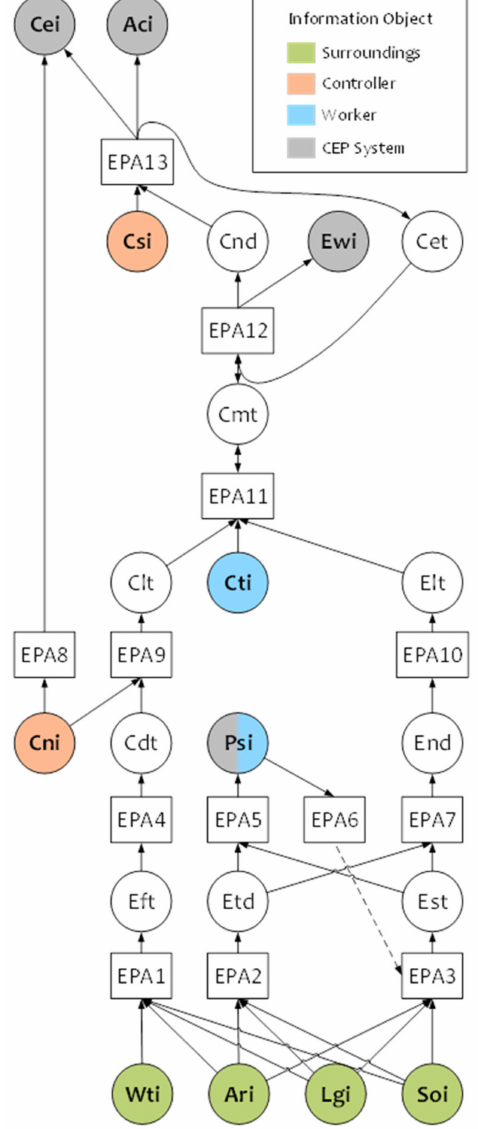
Figure 2. The general structure of a complex event processing engine facing a